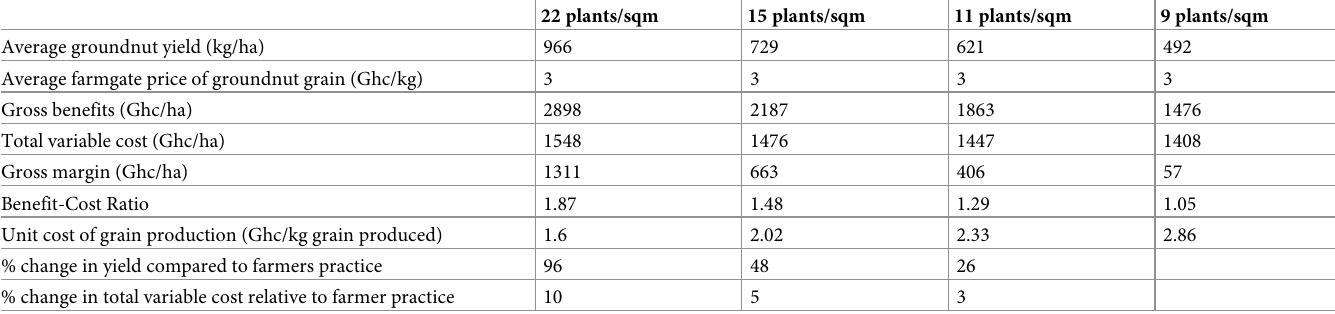
Table 1. Partial budget analysis of on-farm groundnut spacing trials.